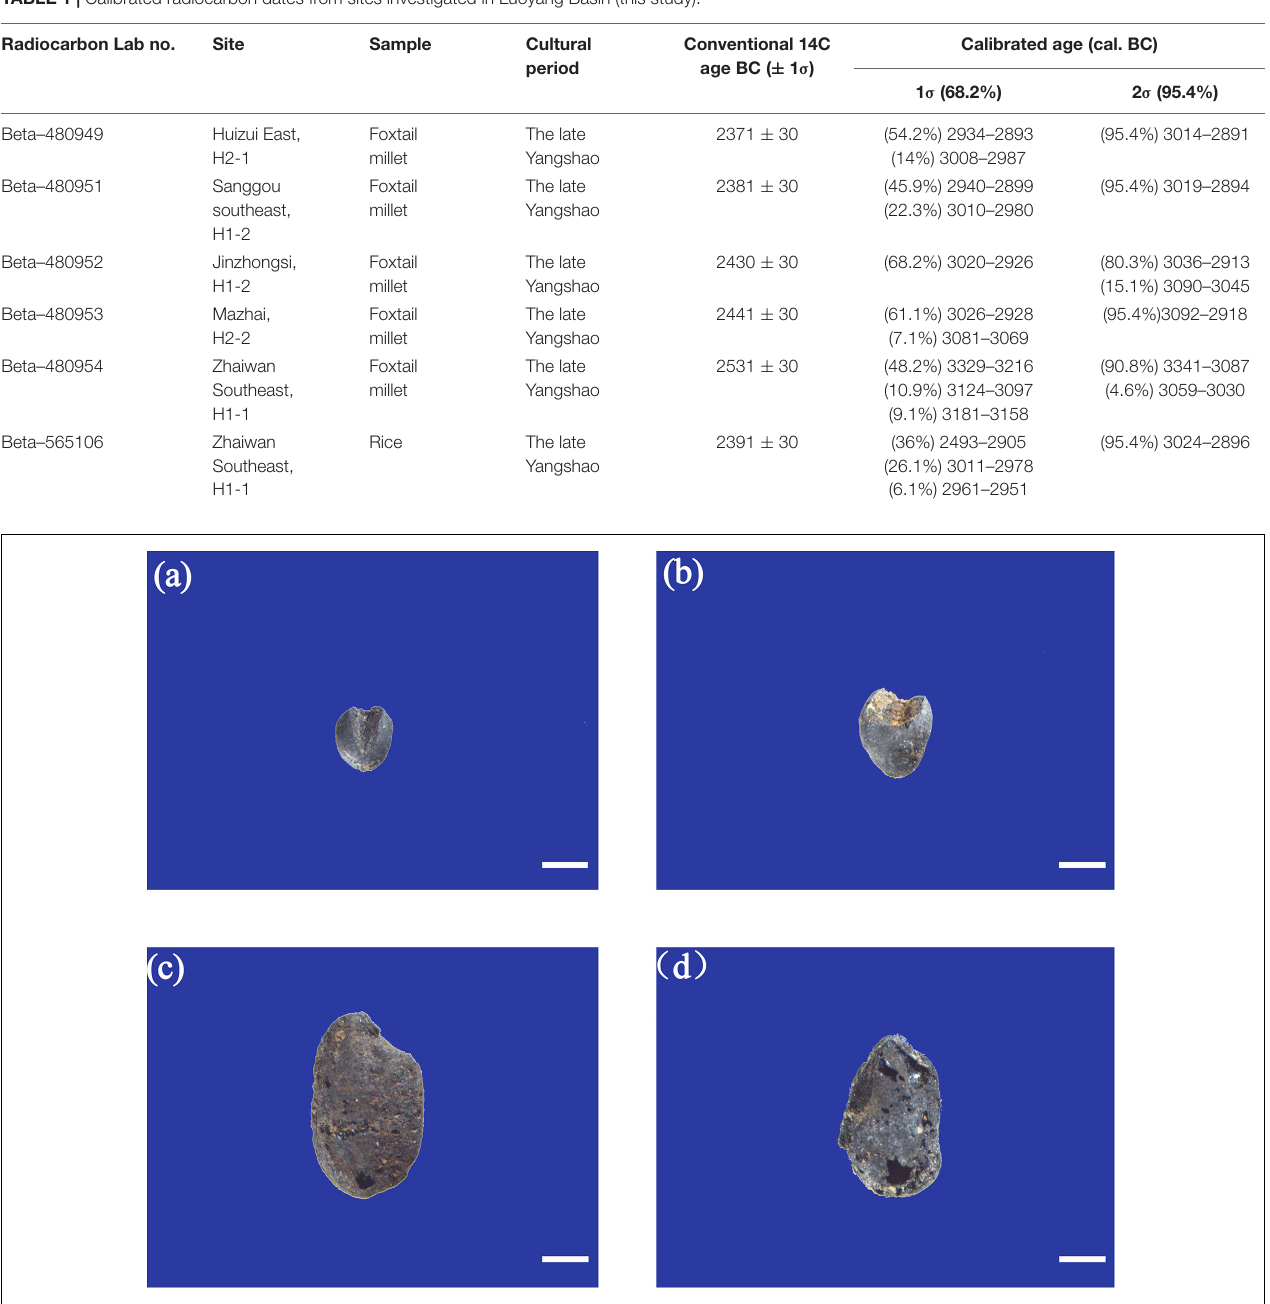
FIGURE 2 | Carbonized crop seeds recovered from Yangshao Culture sites in the Luoyang Basin (Scale bar: 1 mm). (a) Foxtail millet ( S. italica ) from Huizui (H2-1); (b) Broomcorn Millet ( P. miliaceum ) from Huizui (H2-1); (c) Rice ( O. sativa ) from Zhaiwan (H1-1); (d) Soybean ( G. max ) from Gaoya